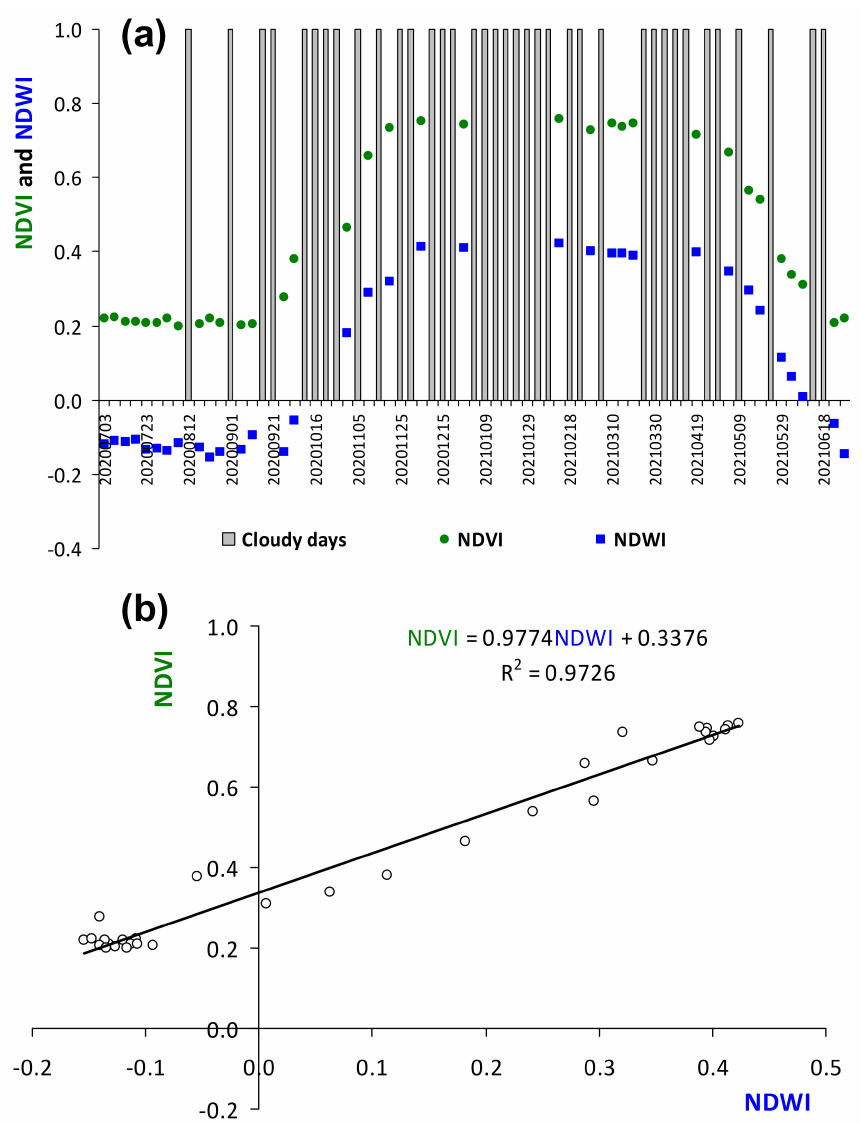
Figure 15. ( a ) Time series records of normalized difference vegetation index (NDVI) and normal- ized difference water index (NDWI) obtained in sampling pixels between July 2020 and June 2021; ( b ) relationship between NDVI and